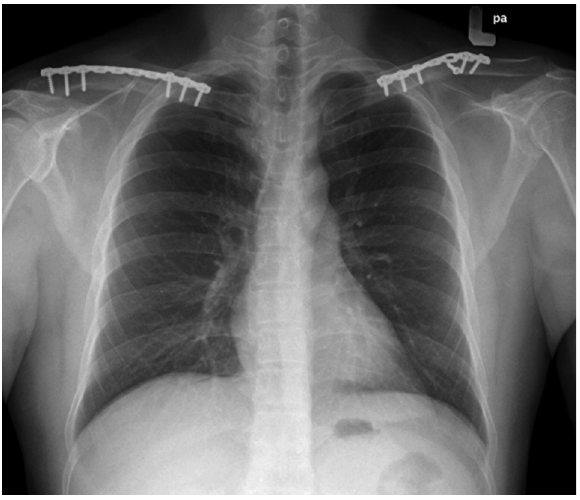
Union of fractures at 5th month post operation seen. Fig. 1c: